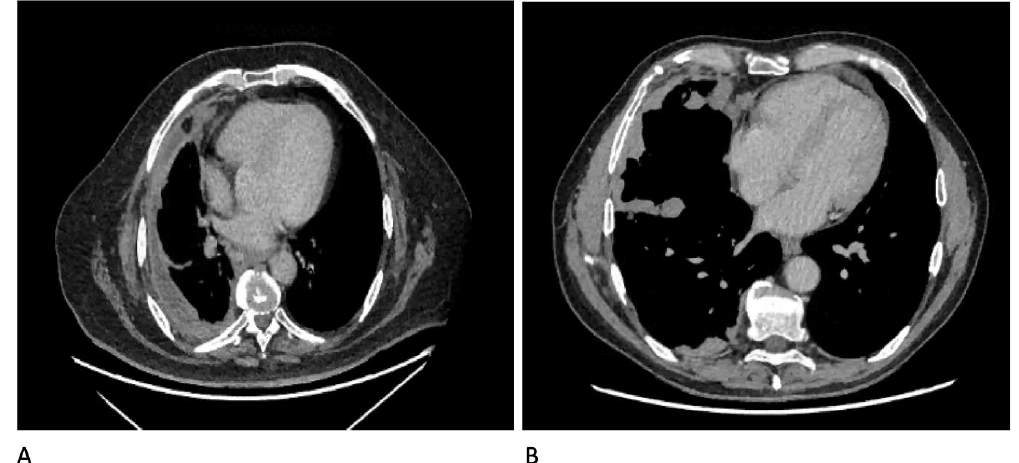
Figure 9. CT images showing some features of malignant pleural disease: ( A ) Circumferential pleural thickening; ( B ) Nodular pleural thickening involving mediastinal surfaces and fissures.